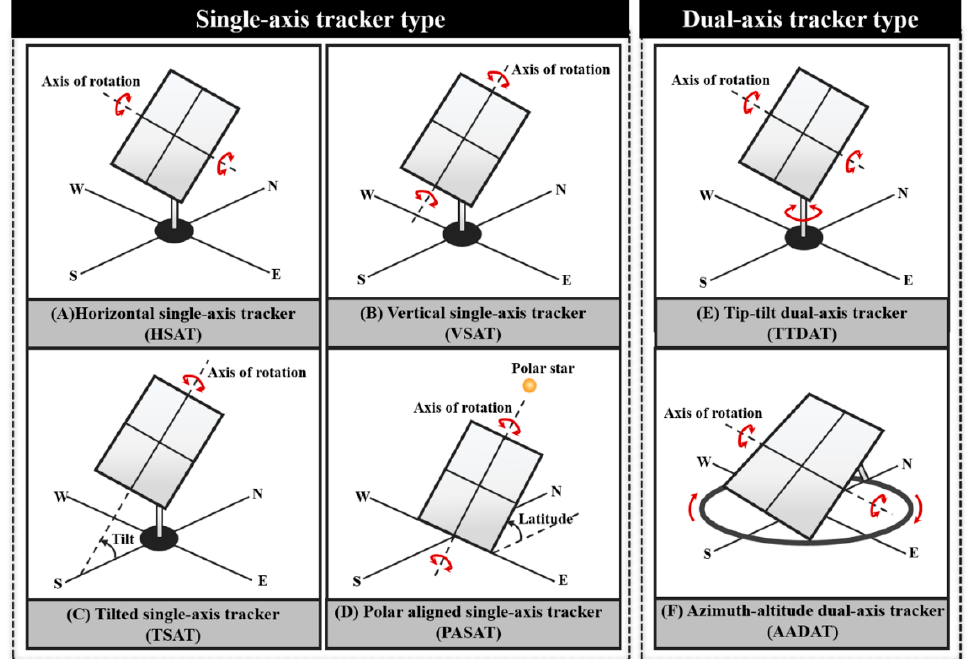
Figure 2. Single- and dual-axis tracker types.